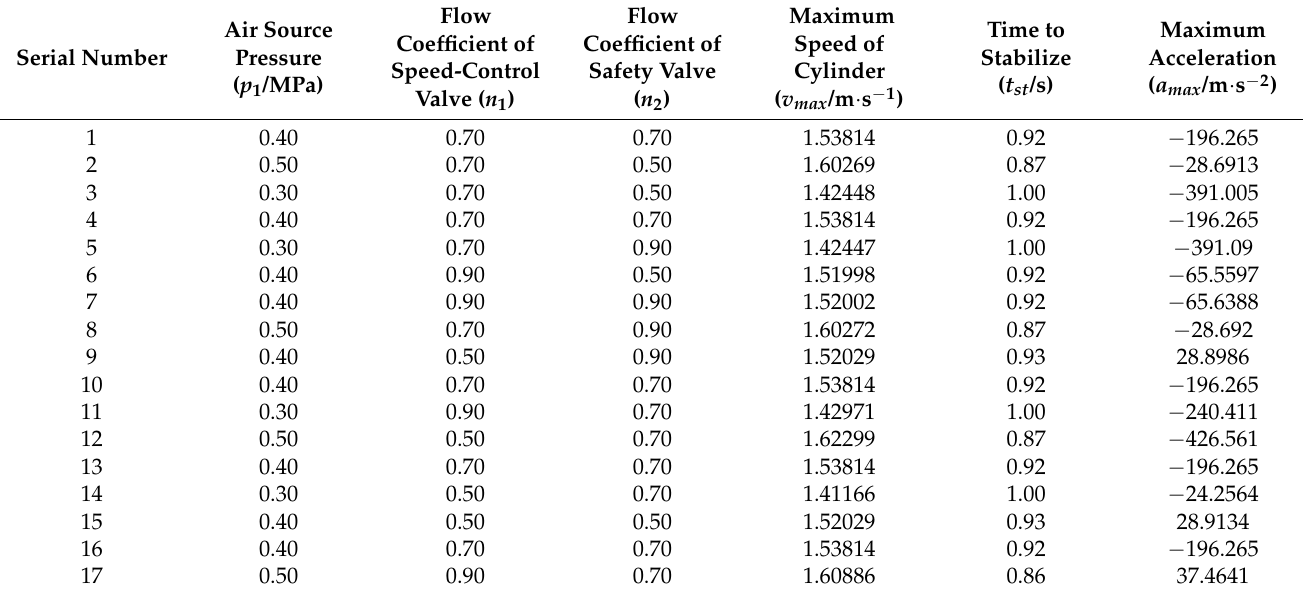
Table 5. Aerodynamic parameter response surface test